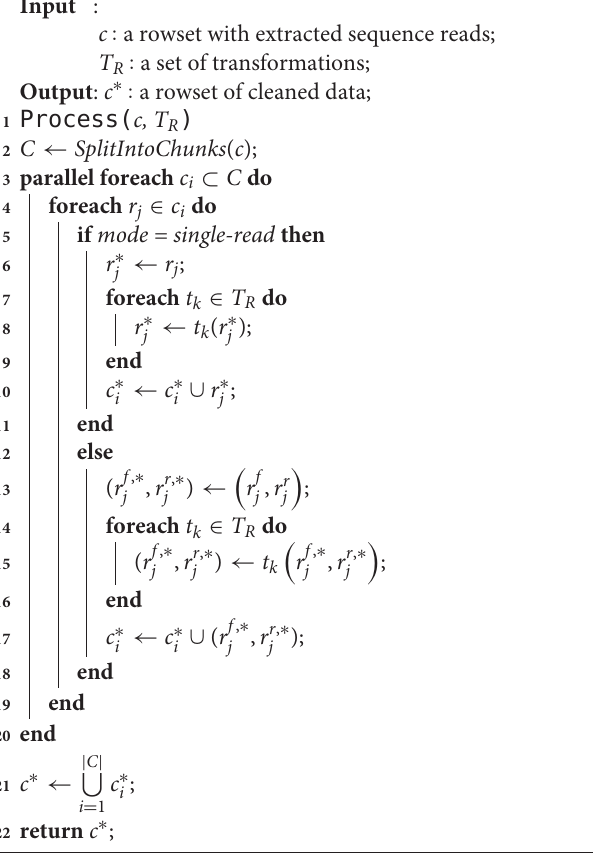
Algorithm 3: Processing a row-oriented data partition (a rowset) from a single NGS data file (or a pair of files for the paired-end